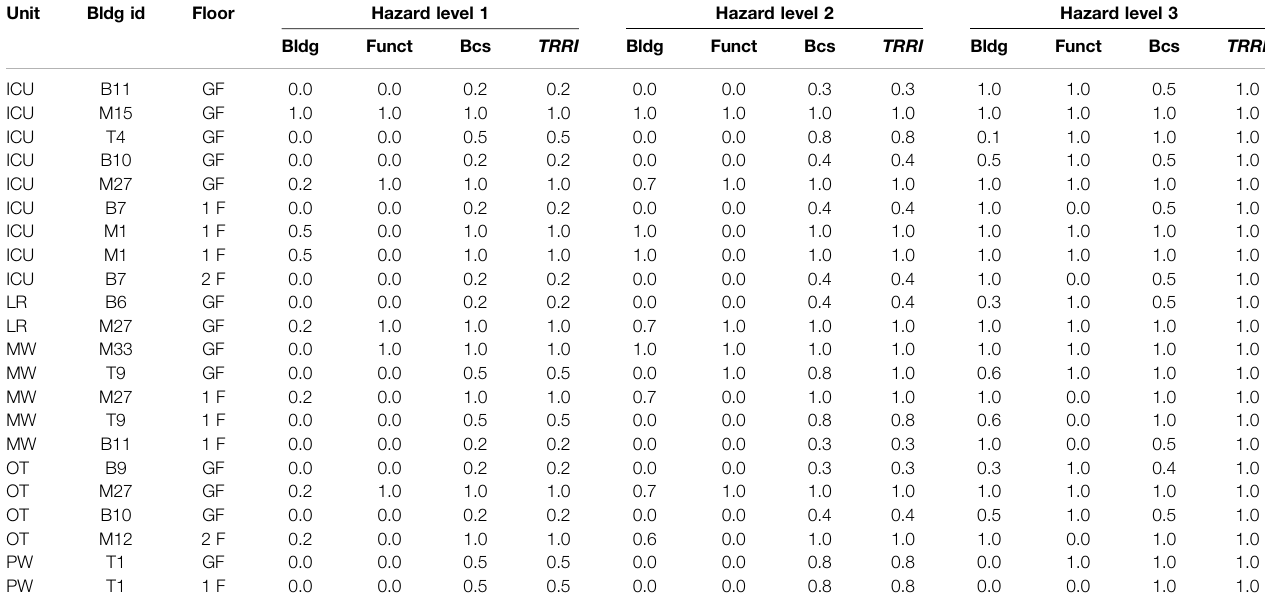
TABLE 4 | Summary of TRRI calculated for the critical units under three hazard levels. Unit